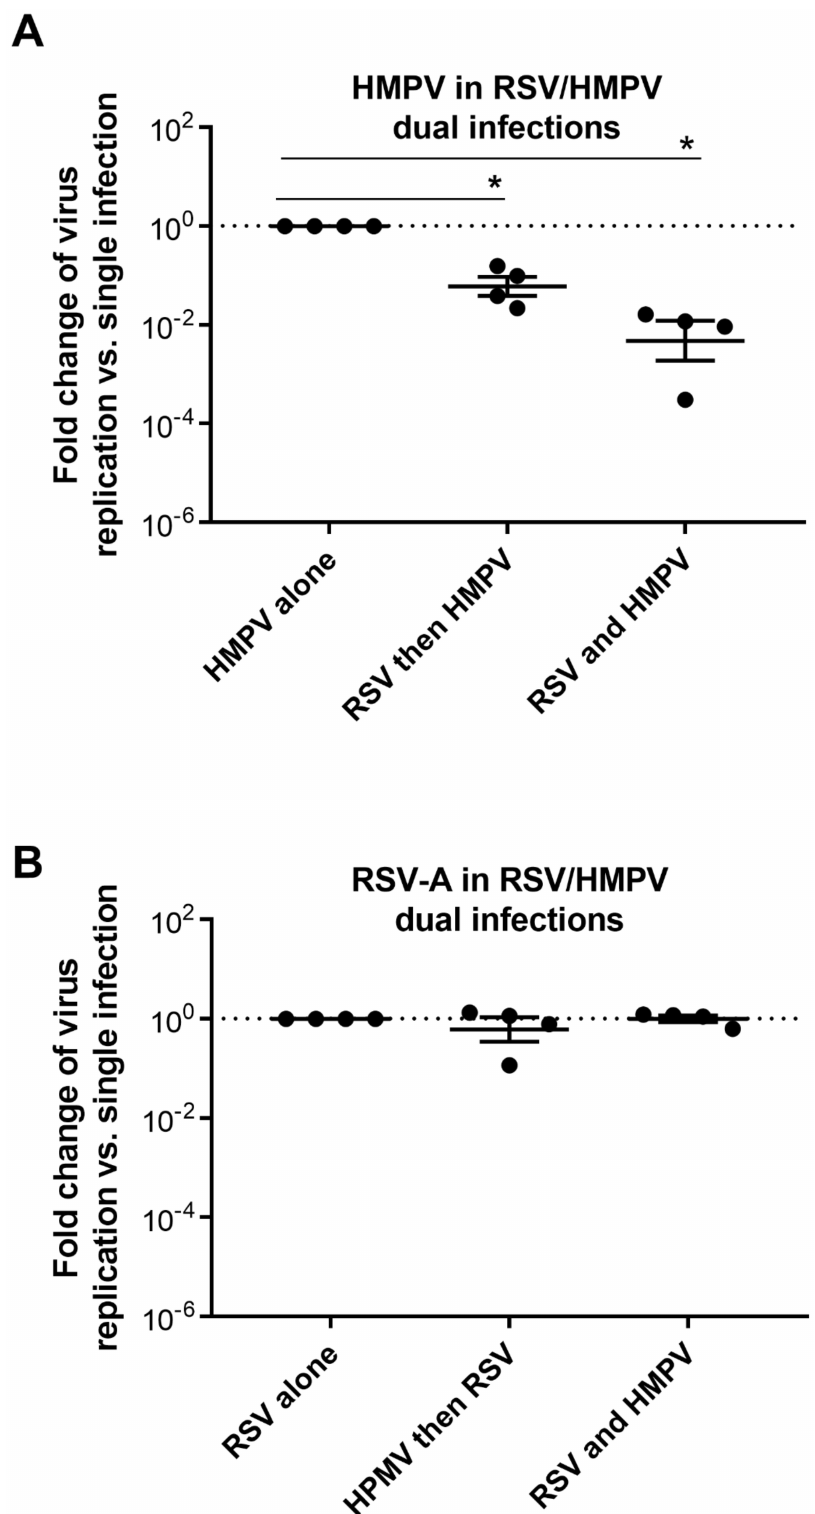
Figure 3. RSV–HMPV dual infections in in vitro reconstituted tissues. HMPV–RSV dual infections were performed in MucilAir TM . Apical replications of HMPV ( A ) and RSV ( B ) in sequential (with an interval of 2 days) and co-infections versus single infections were quantified 5 dpi by RT-qPCR. Fold changes in viral replication compared to a single infection are represented in decimal logarithm. Statistical significance calculated using the two-way ANOVA, N = 4, was shown (* p <